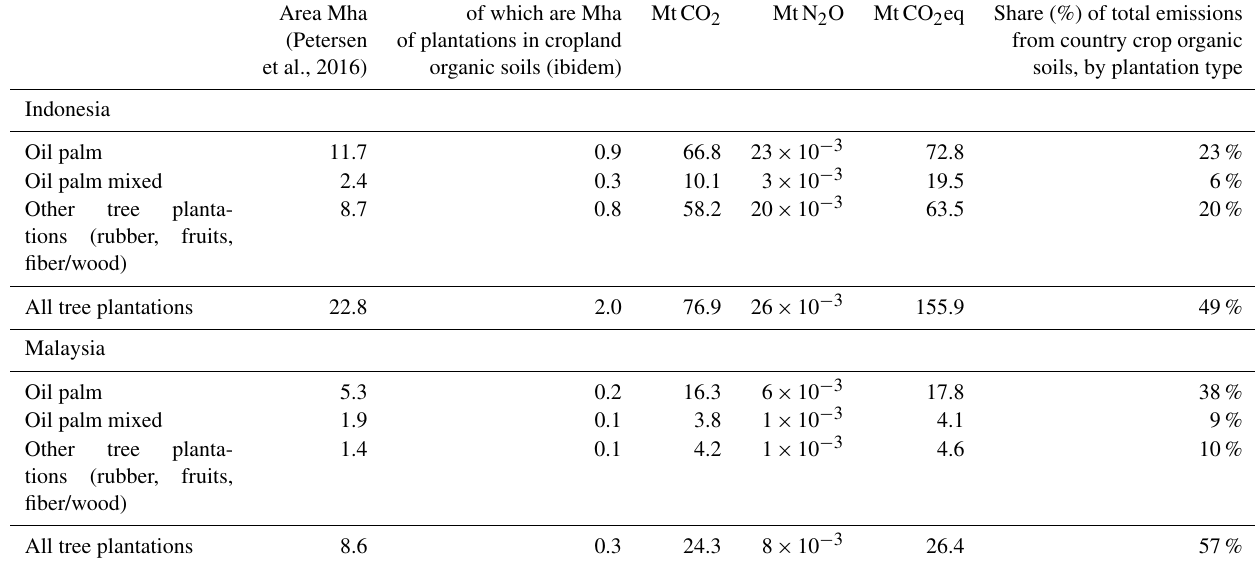
Table 7. Area of oil palm and other tree plantations (mapped from Petersen et al., 2016) and their distribution in cropland organic soils and corresponding emissions in Indonesia and Malaysia in 2014. Share of total emissions by type of plantation from the country-level cropland organic soils is also shown. In 2014, total emissions from cropland organic soils were 318MtCO 2 eq in Indonesia and 45MtCO 2 eq in Malaysia. Area Mha of which are Mha MtCO